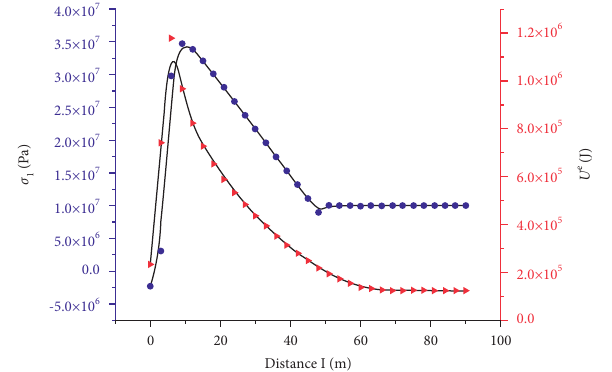
Figure 13: Relationship between σ cut by hydraulic fracturing surface horizontally.